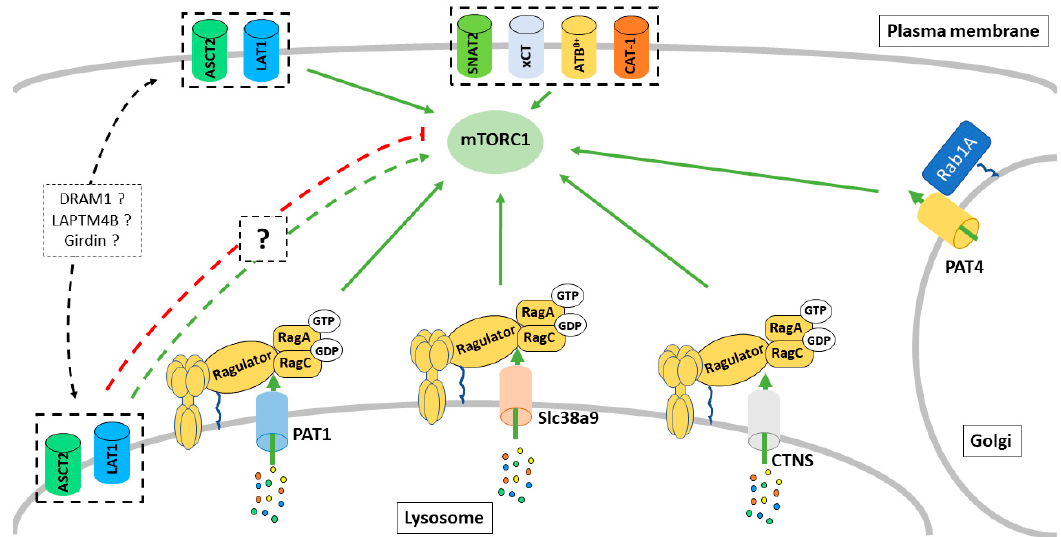
Figure 3. Intracellular amino acid transporters regulate mTORC1 activity. Multiple intracellular transporters have been shown to regulate mTORC1 via possibly Rag GTPase-dependent and independent mechanisms.